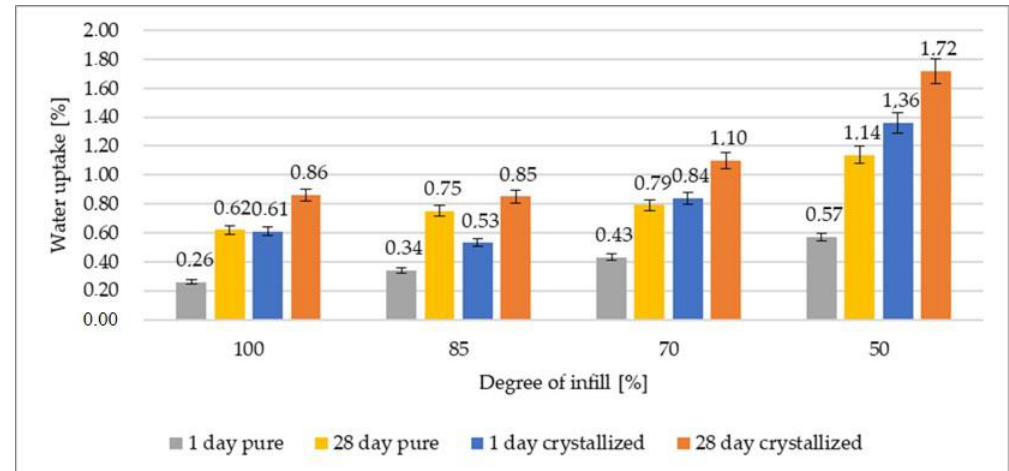
Figure 4. Weight gain resulting from hydrolytic degradation after soaking pure and crystallized samples for 1 and 28 d.